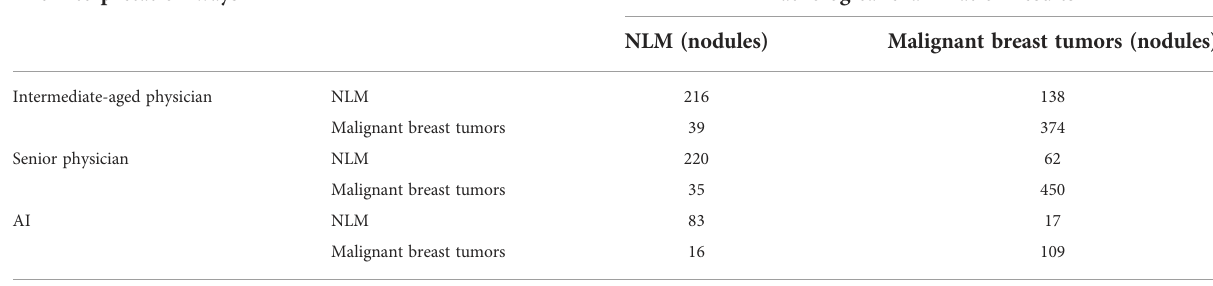
TABLE 2 The interpretation results by intermediate-aged/senior physicians based on working experience.